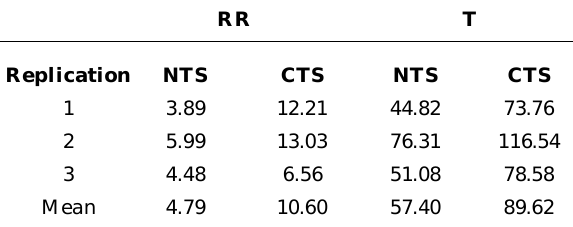
NTS : no-tillage soil; CTS: conventionally tilled soil.